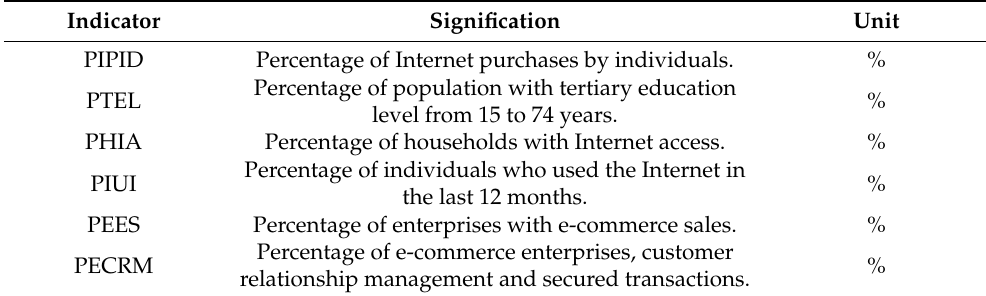
Table 2. List of used variables.